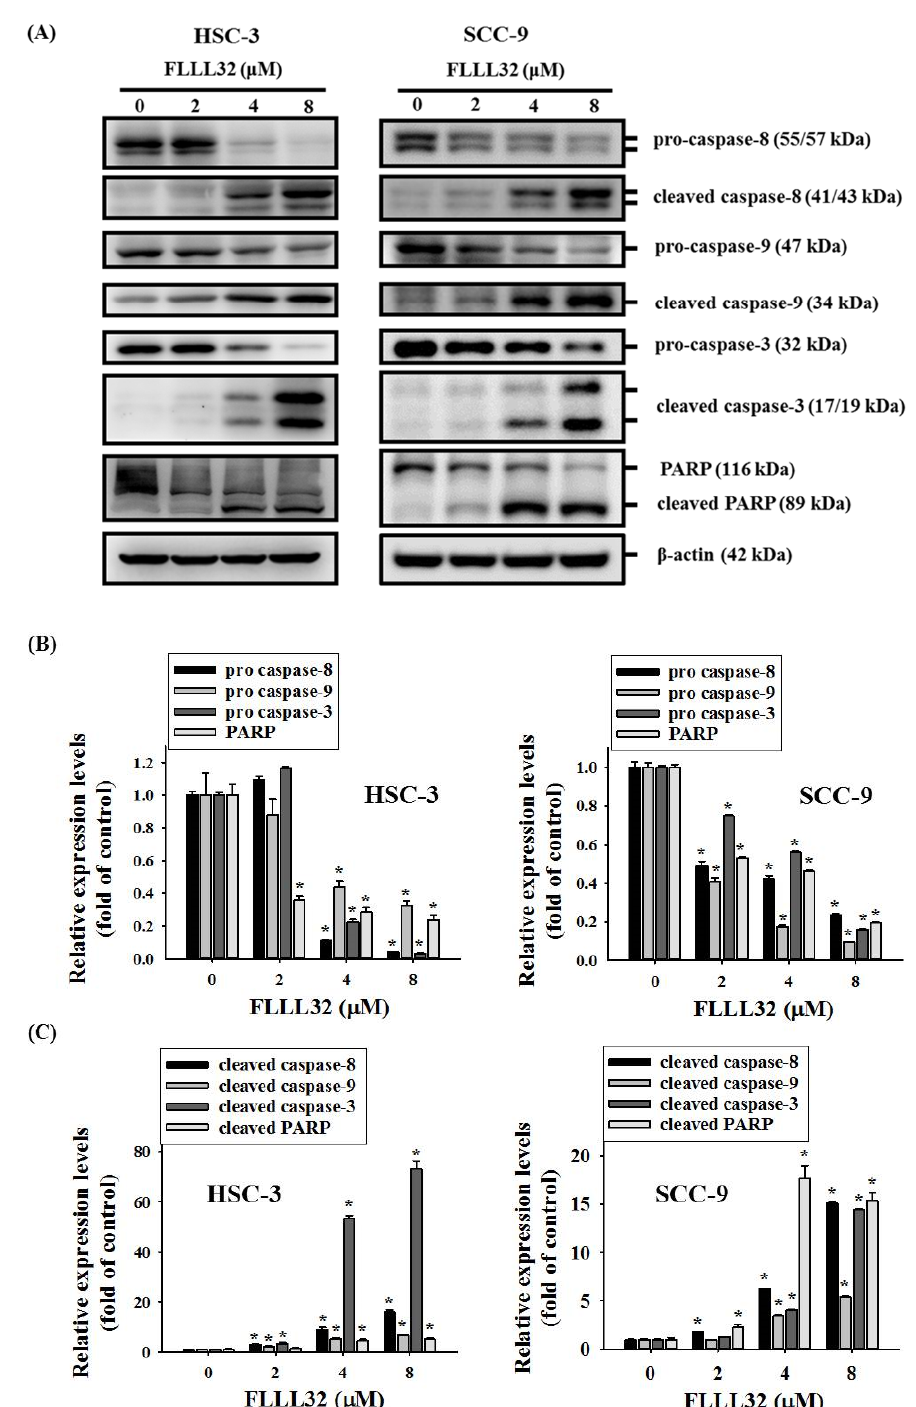
Figure 5. FLLL32 induces the activation of caspase-8, -9, -3, and PARP in oral cancer cells. ( A ) HSC-3 and SCC-9 cells were treated with FLLL32 (0, 2, 4, or 8 μ M) for 24 h, and the protein levels of pro- and cleaved caspase-8, -9, -3, and PARP were analyzed by Western blot. The β -actin protein was used as a loading control. ( B ) Quantitative results of pro-caspase-8, -9, -3, and PARP from ( A ). ( C ) Quantitative results of cleaved caspase-8, -9, -3, and PARP from ( A ). β -actin protein levels were used to adjust the quantitative results of protein levels; * p < 0.05 compared with the vehicle group.